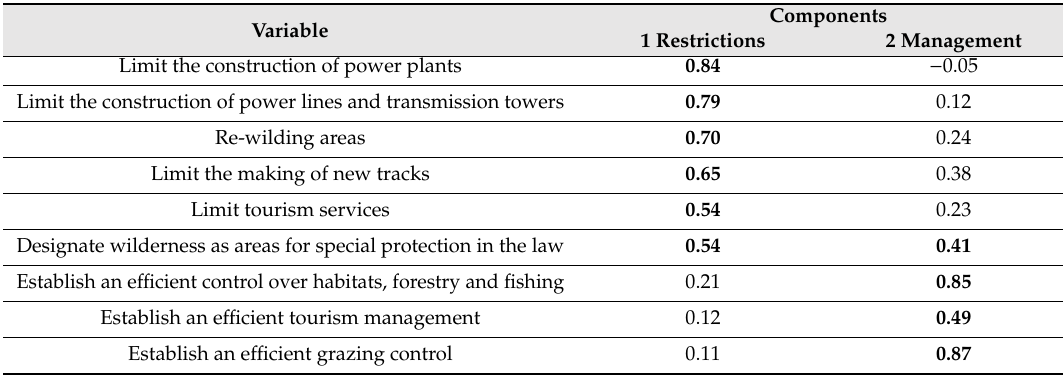
Figure 12. Important actions in order to conserve Icelandic wilderness. Table 2. Principal component analysis of important conservation action.